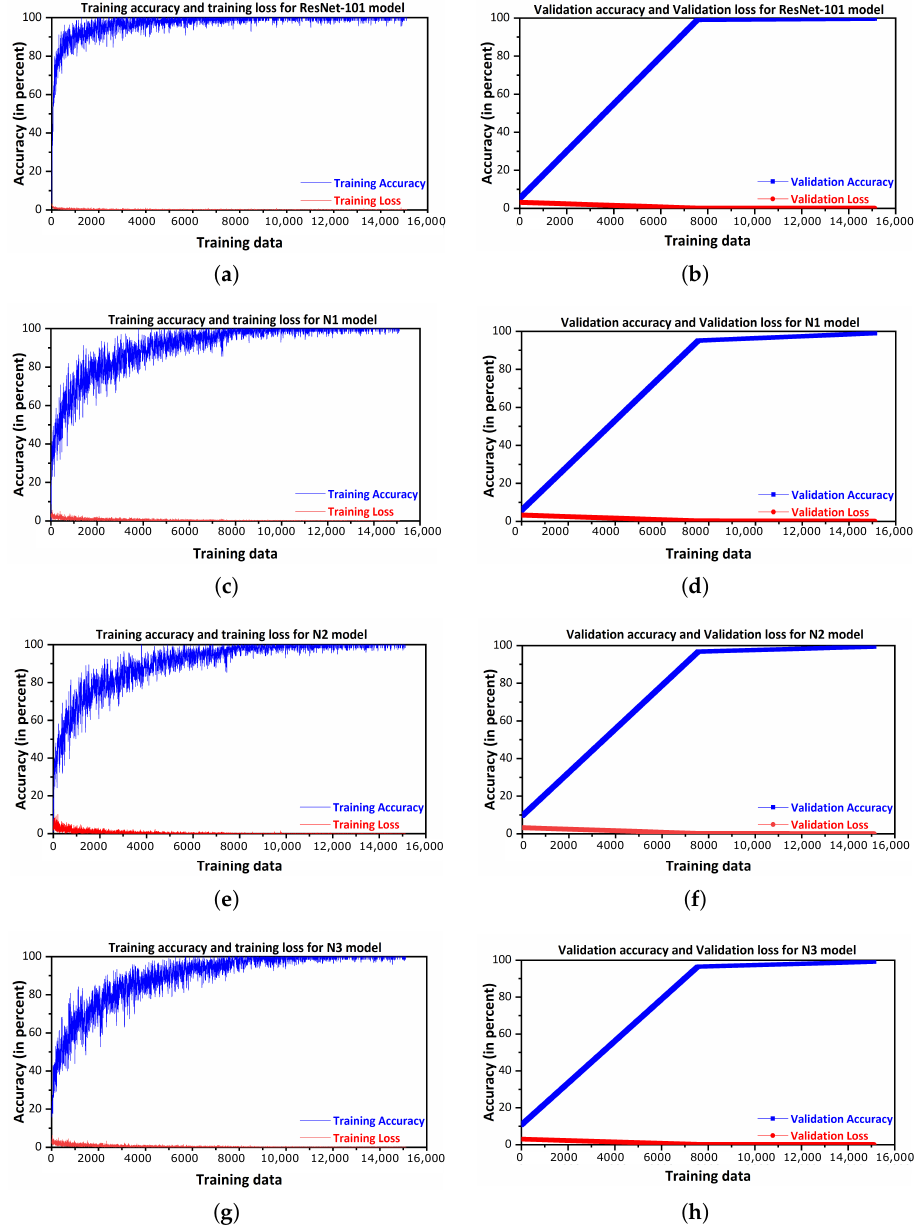
Figure 7. TL, VA, and VL were calculated for the ResNet-101 and N1, N2, and N3 models. The tomato plant images were classified with the ResNet-101 model with transfer learning and the proposed N1, N2, and N3 models, as shown in Figure 8. For TPD classification, each model was trained with 80% of the dataset and tested with 20% of the dataset. The classified images with the N1 model are shown in Figure 8a. Figure 8b depicts the N2-classified images. Figure 8c illustrates images classified by the N3 model, and Figure 8d shows images classified by the ResNet-101